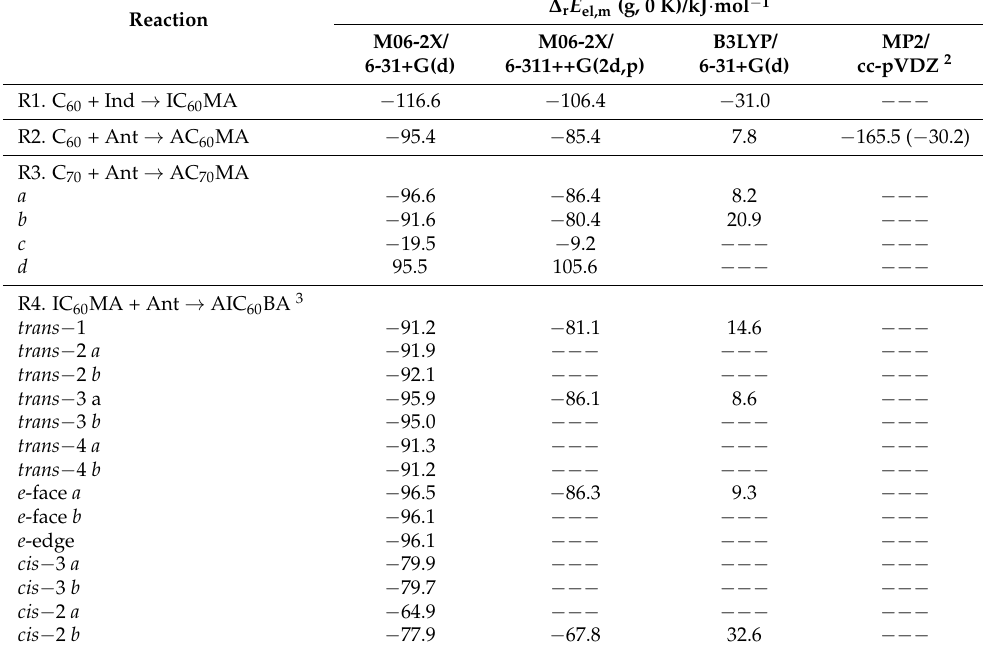
Table 1. Electronic energies of reaction in vacuum, at T = 0 K, for the Diels–Alder cycloadditions of the fullerenes studied with indene (Ind) and anthracene (Ant), calculated at various levels of theory; all geometries optimized using M06-2X/6-31+G(d) 1 .